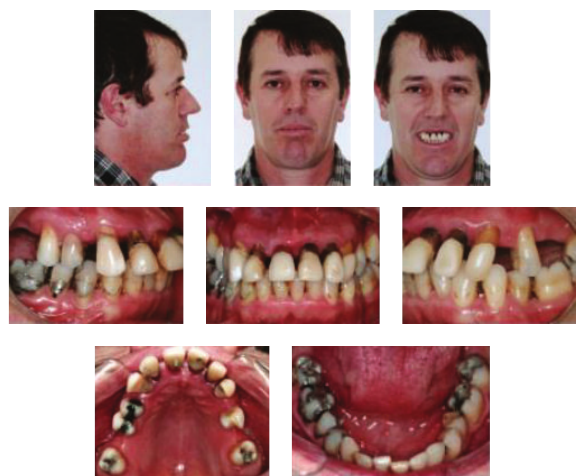
Figure 1: Pretreatment facial and intraoral photographs.